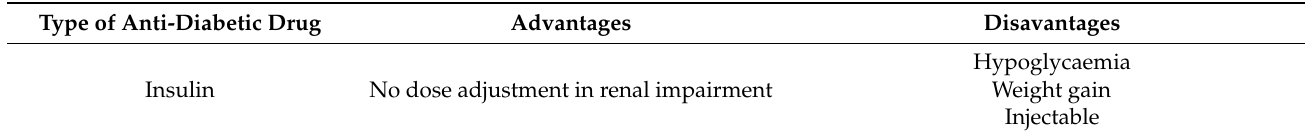
Table 3. Therapeutic groups for PTDM according to advantages and disadvantages